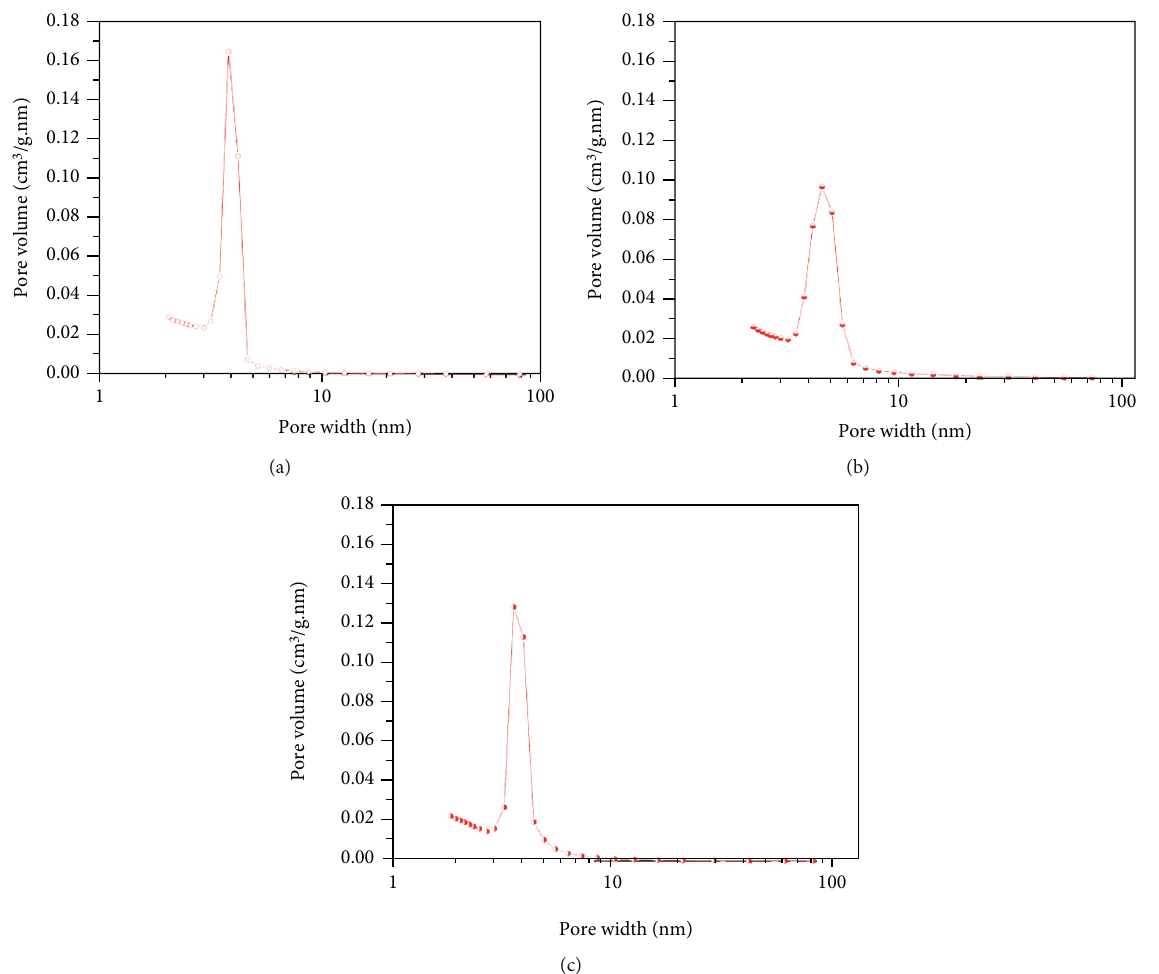
-1%Co, (b) TiO 2 samples. 2